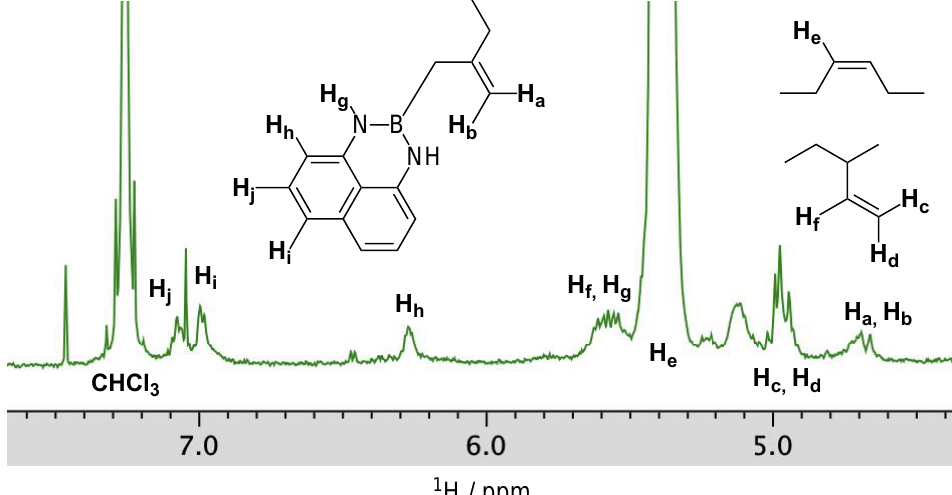
Figure 2. The 1 H NMR spectrum of butadiene/ 2a copolymer obtained in Table 1, run 5 (500 MHz, in CDCl 3 ).